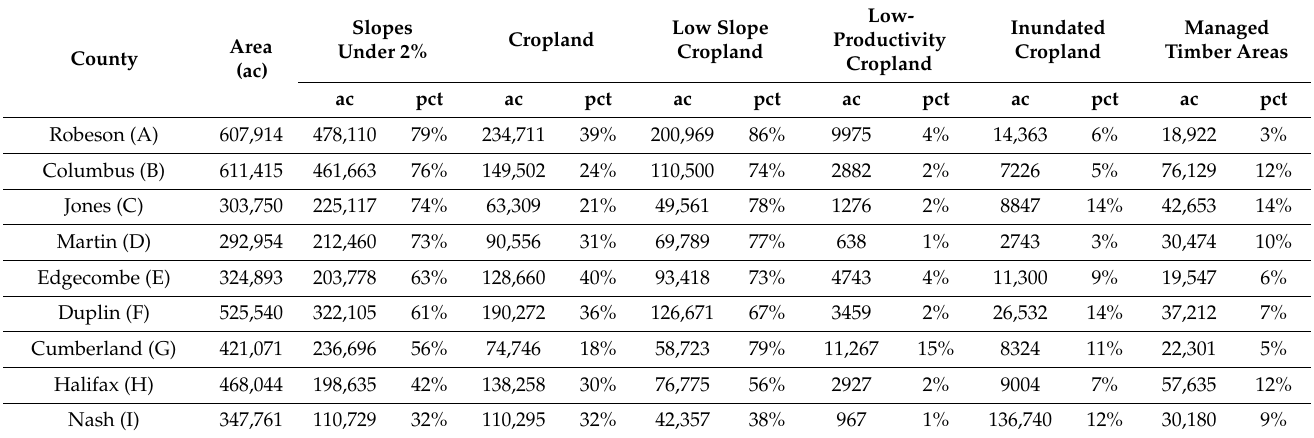
Table 2. Initial County Analysis and